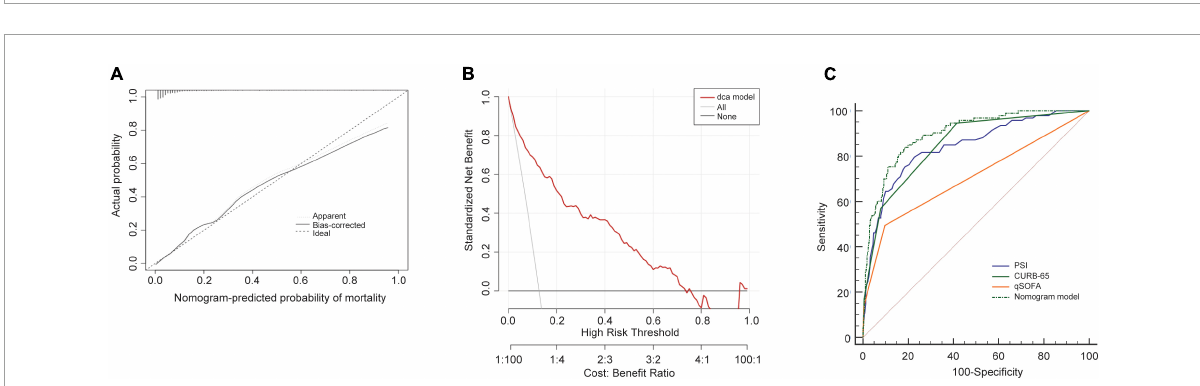
FIGURE4 Performance of the nomogram model in training cohort. (A) Calibration curves for predicting the mortality in the training set. (B) Decision curve analysis for the predict-ed-nomogram model of mortality in the training set. (C) The receiver operator characteristic curves (ROC) of the nomogram model, PSI, CURB-65 and qSOFA in training cohort for evaluating the risk of in-hospital mortality in older patients with CAP. CURB-65: confusion, urea, respiratory rate, blood pressure, and age ≥ 65 years; qSOFA, quick Sequential Organ Failure Assessment; PSI, Pneumonia Severity Index.